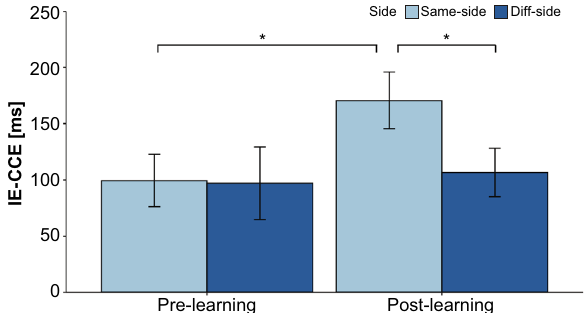
Figure 3. IE-CCE score. The IE-CCE is displayed for each pre - / post- learning, and the results are compared for the ipsilateral and contralateral conditions. Error bars represent the variability among the subjects for each condition. Pairwise comparisons by adjusting p value for which a statistically significant difference ( adj . p < 0.05 ) can be confirmed are indicated by an asterisk (*). *... adj . p < 0.05 .